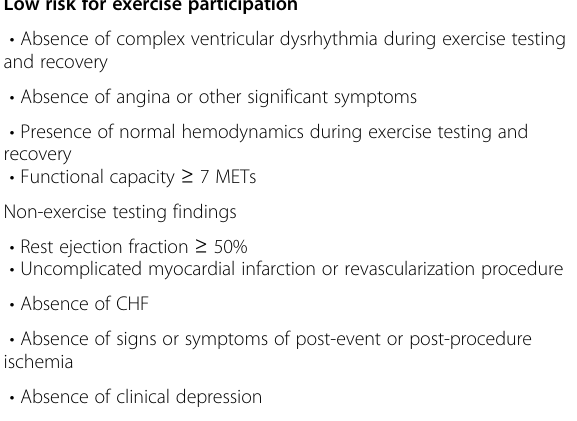
Table 3 Characteristics of patients based on risk stratification [7, 9] Low risk for exercise